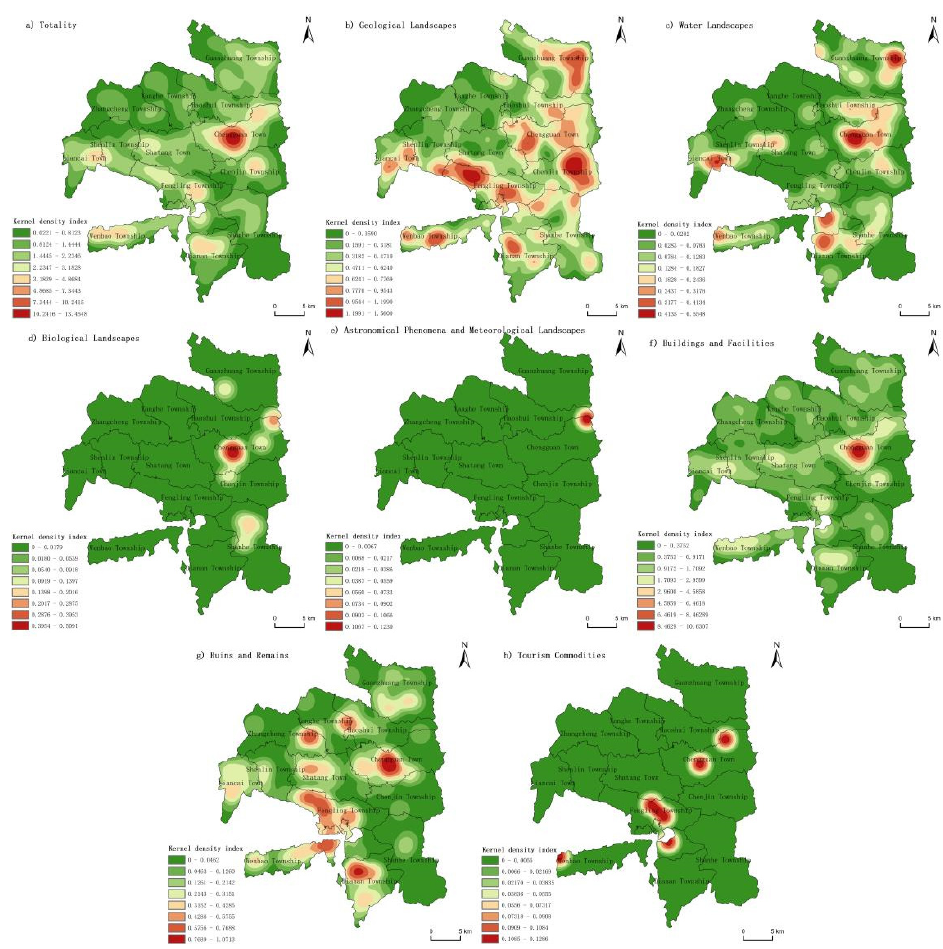
Figure 6. Kernel density of various types of tourism resources in Longde County.